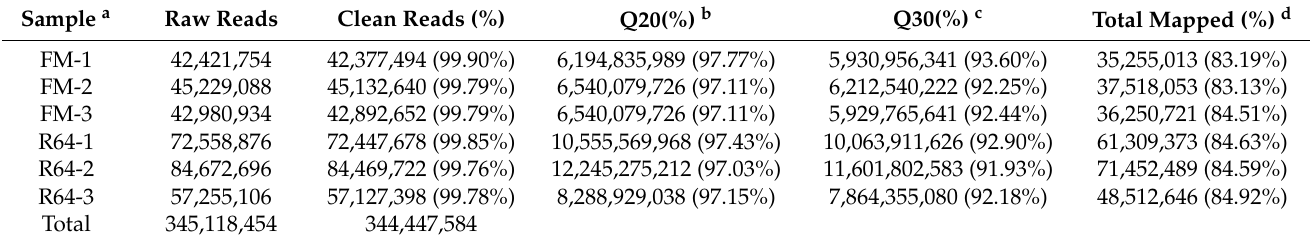
Table 5. Summary of statistics for Illumina short reads of the liver transcriptome of S. sihama